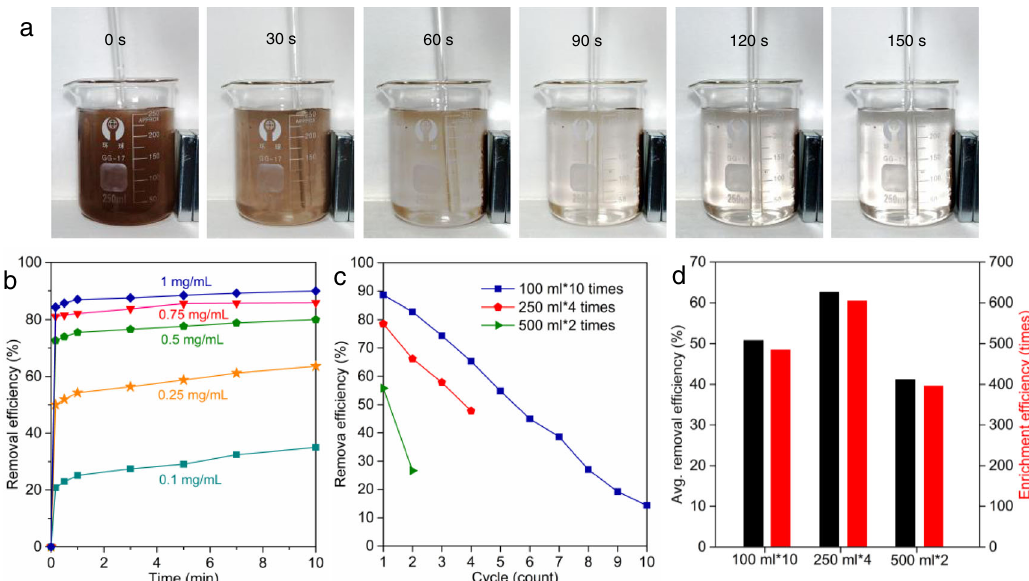
Fig. 3 Rapid enrichment performance of MN-PCDP. a Optical photographs of MN-PCDP separation process by a magnet in continuous time. b Time- dependent adsorption of BPA (0.1 mM) using MN-PCDP with different dosage (0.1, 0.25, 0.5, 0.75, and 1 mg L − 1 ). c Removal ef fi ciency of BPA (0.01 mM) using MN-PCDP (100 mg) in three methods (100 mL for 10 times, 250 mL for 4 times and 500 mL for 2 times). d Average removal (black) and enrichment (red) ef fi ciency of the three methods in ( c Fig. 3b, Supplementary Fig. 12, and Supplementary Table 3. When the concentration increases from 0.1 to 1.0 mg L − 1 , the adsorption ef fi ciency of BPA is enhanced from 25.12 to 87.09% within 1 min and from 35.07 to 89.82% within 10 min.